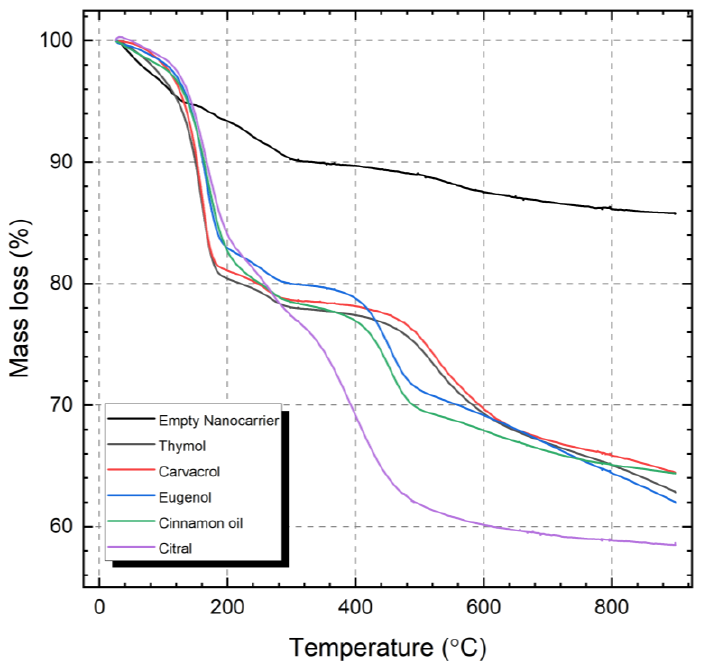
Figure 5. Thermogravimetric analysis of the empty and the loaded nanocarriers.